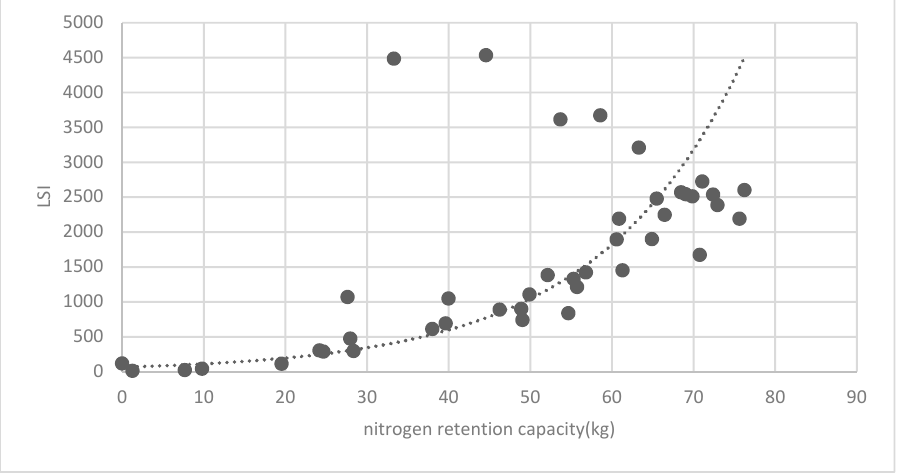
Figure 35. Association between brush LSI and nitrogen retention capacity.